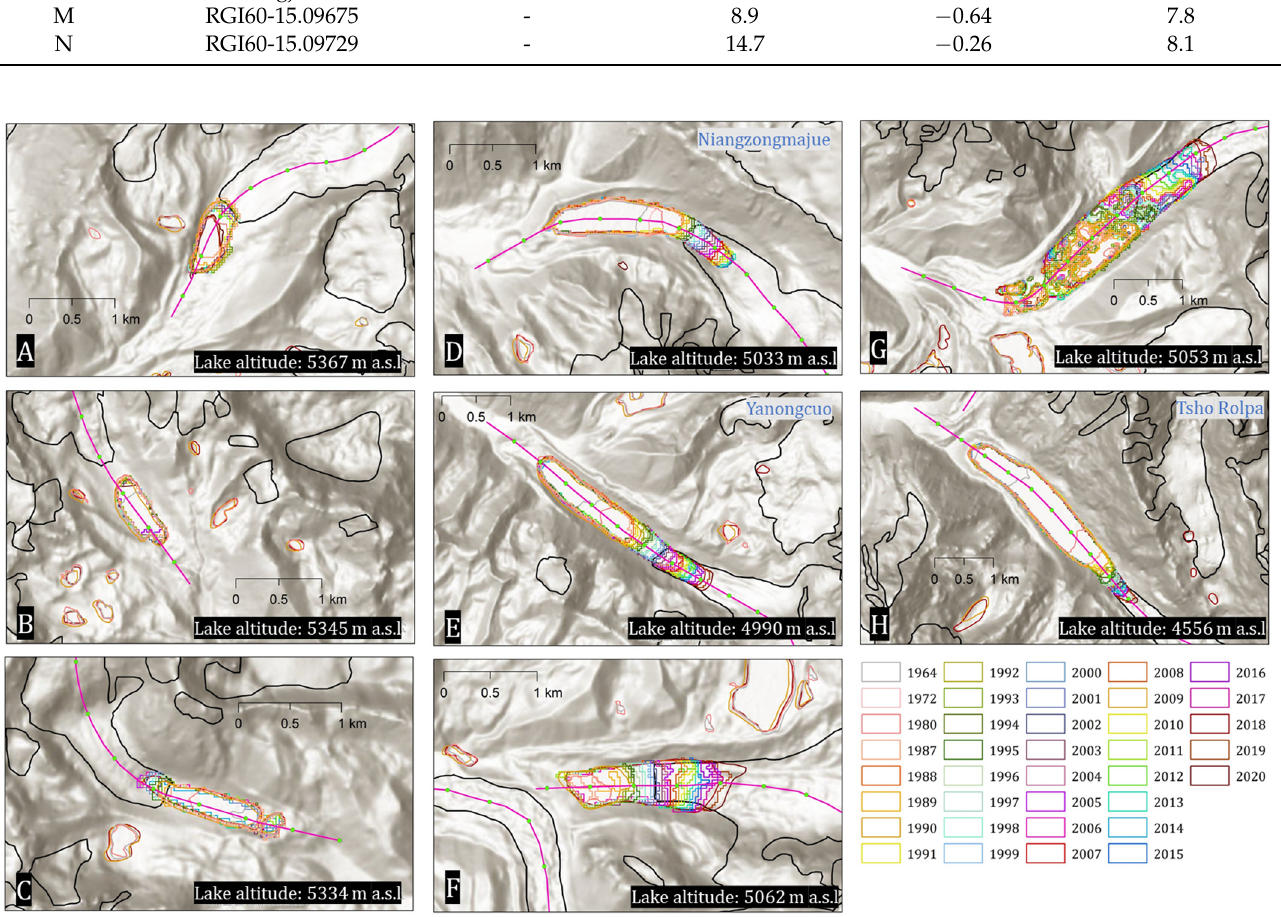
Figure 4. Changes of eight (Lake A – H ) rapidly expanding proglacial lakes in the past 56 years overlayed on the Esri topographic map.